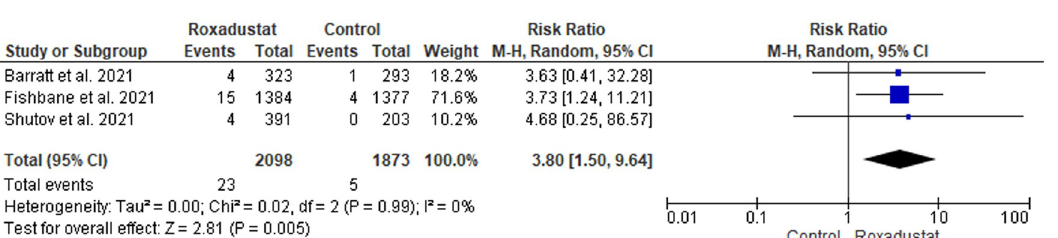
Fig 4. Forest plot of the secondary outcomes. A: serious adverse effect; B; treatment-emergent adverse effects (TEAE); C: hypertension; D: deep venous thrombosis; CI: confidence interval; M-H: Mantel-Haenszel; df: degrees of freedom; I 2 , I-squared.